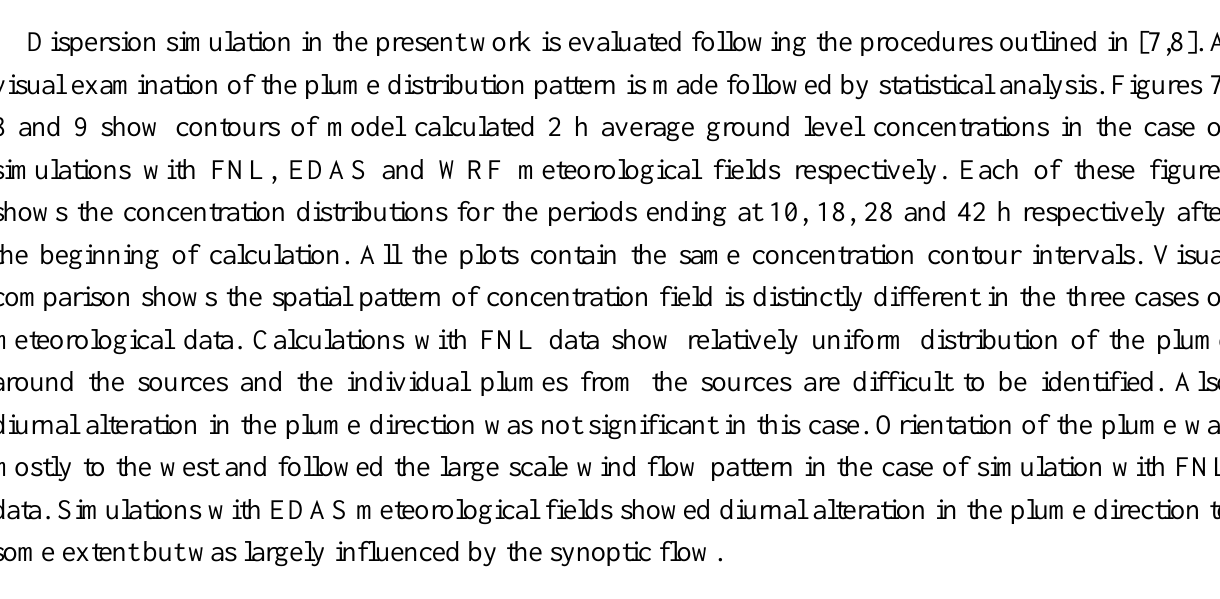
Figure 8. Simulated SO plume concentration distribution using Eta AWIP data at 08-10 2 UTC, 01 June 06, 16-18 UTC 01 June 06, 02-04 UTC 02 June 06 and 20-22 UTC 02 June 06 respectively.